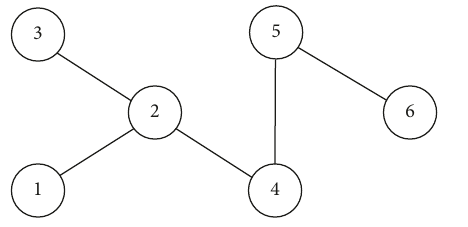
Figure 3: Initial mode of interaction topology.